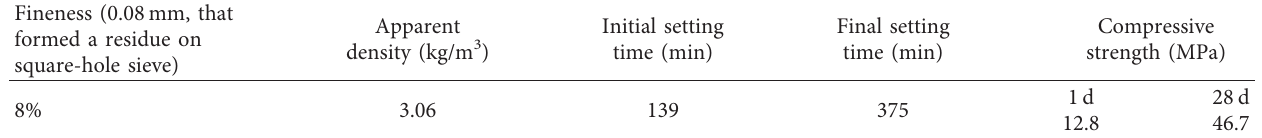
Table 2: Physical performance of OPC.